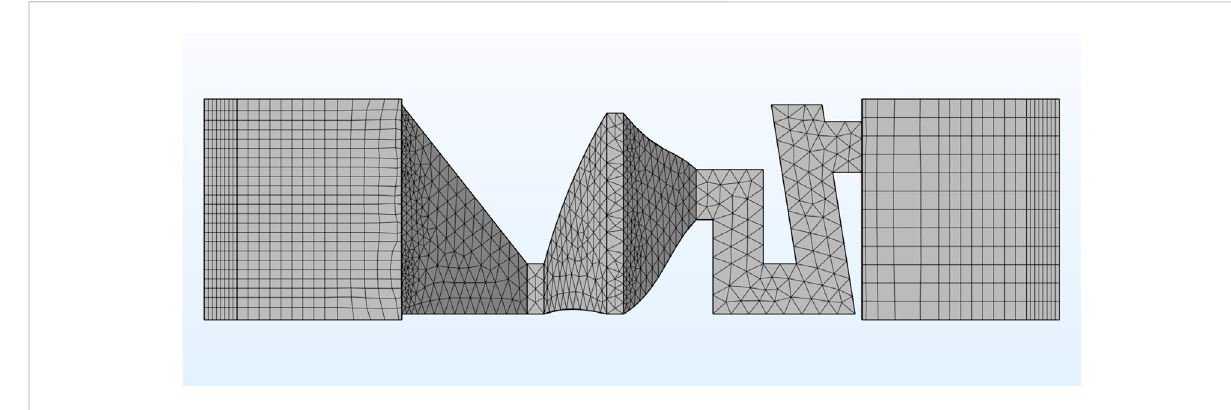
FIGURE 2 The mesh division of the cavity